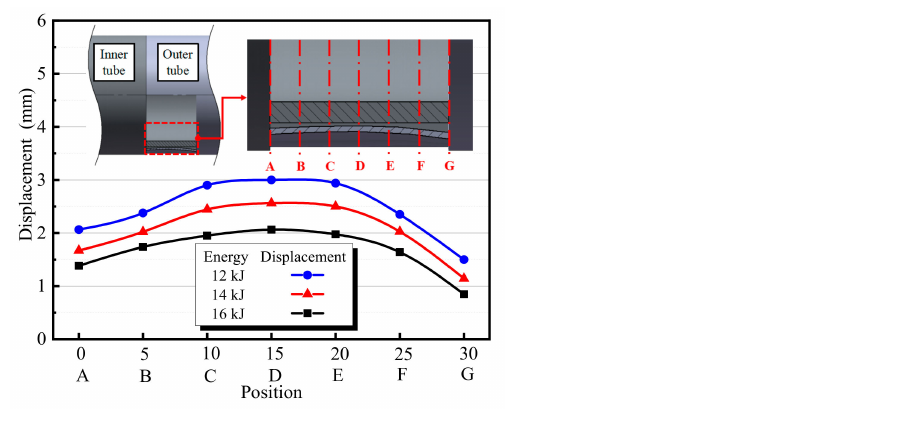
Figure 9. The maximum deformation of the outer tube at various positions under different discharge energies.